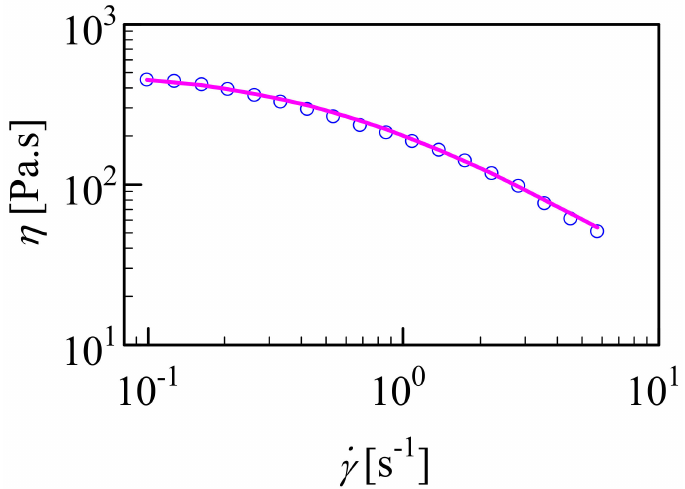
Figure 3. Shear viscosity versus shear rate for HA (M w : 132.3 kDa)/CHI (F A = 0.42) coacervate. Line shows fitting of the data to Carreau model given in Equation